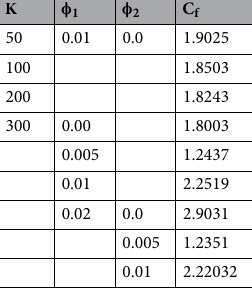
Table 4. Behavior of skin friction coefficient ( C f ) under diverse values of K, φ 1 and φ 2 when Pr = 6.2, (cid:31) =1, Ec = 0.1, M = 0.01 and Rd = 0.5.